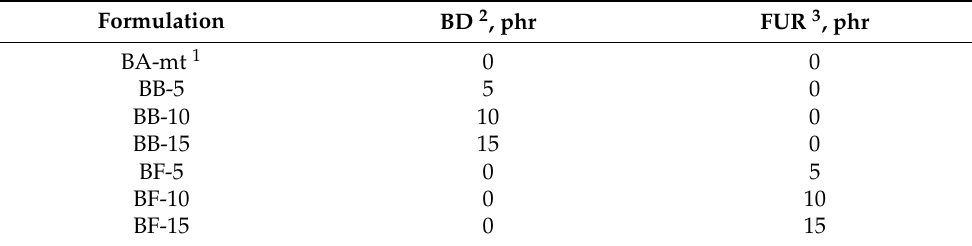
Table 1. Formulations of blends in parts per hundred resin BA-mt (phr).